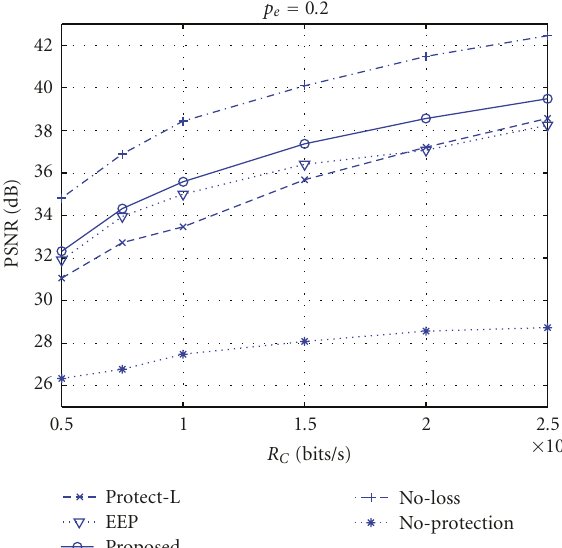
Figure 19: Results for p e = 0 . 05 for “Rena” video.